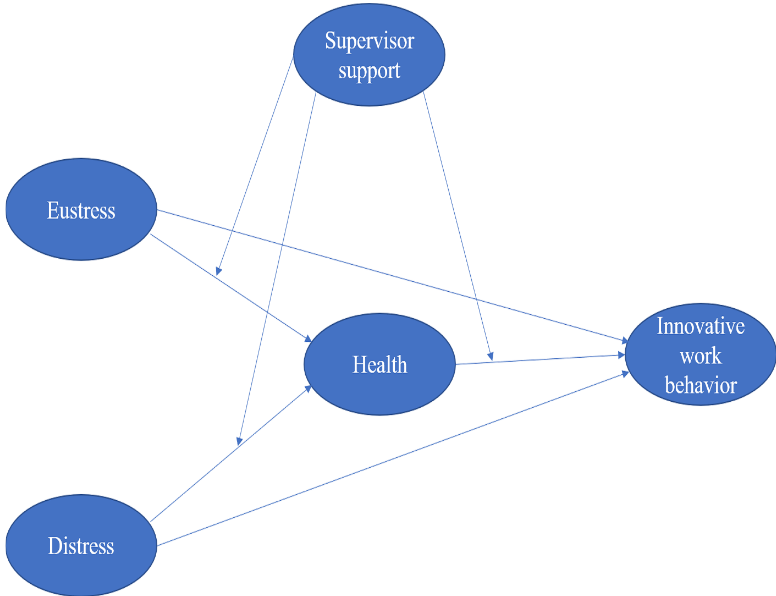
Figure 1. Proposed model of the study.